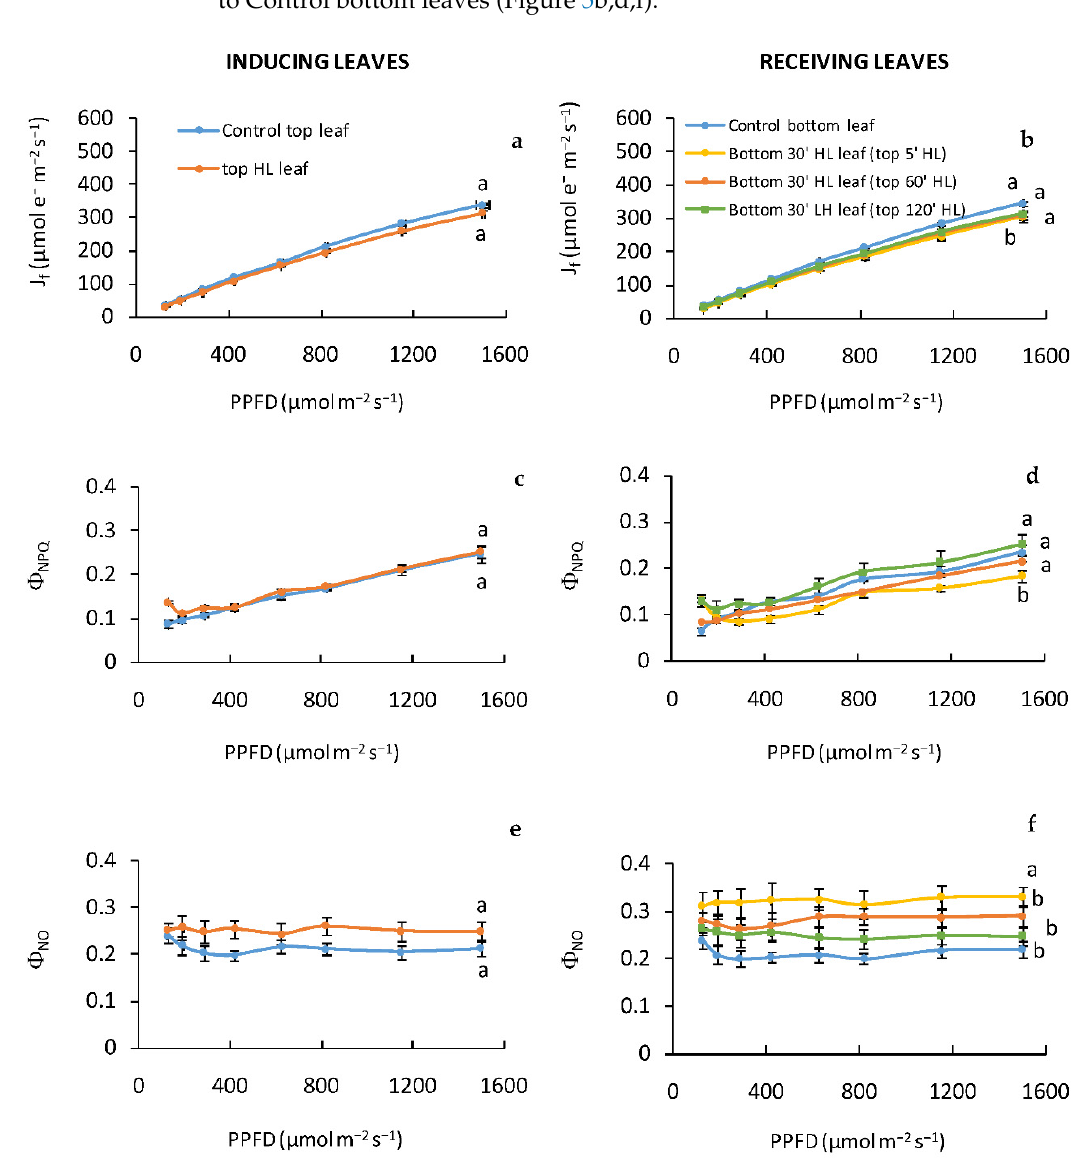
Figure 5. Fast kinetic light response curves: electron transport rate (J f ) ( a , b ), quantum yield of regulated energy dissipation ( Φ NPQ ) ( c , d ), quantum yield of non-regulated energy dissipation ( Φ NO ) ( e , f ) in P. vulgaris L. Control, Top HL “inducing”, and Bottom HL “receiving” leaves. Different letters indicate statistically significant difference among treatments ( p ≤ 0.05) by One-Way ANOVA followed by Holm–Sidak post-hoc test.